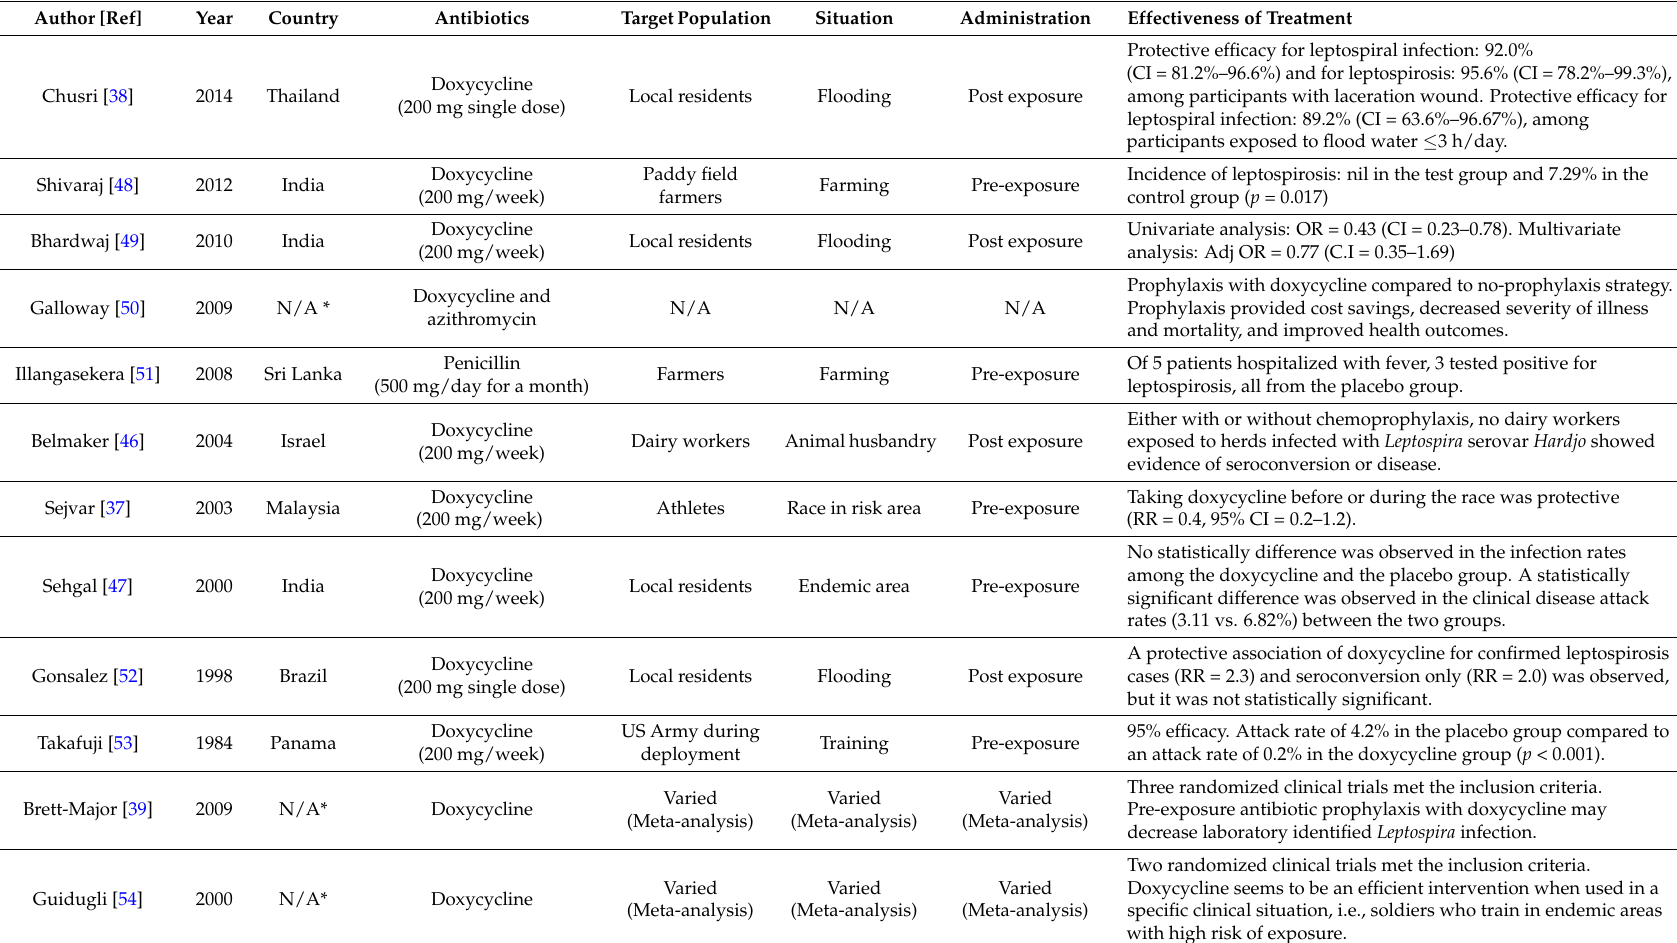
Table 2. Summary of quantitative studies and systematic reviews on the effectiveness of chemoprophylaxis for leptospirosis.